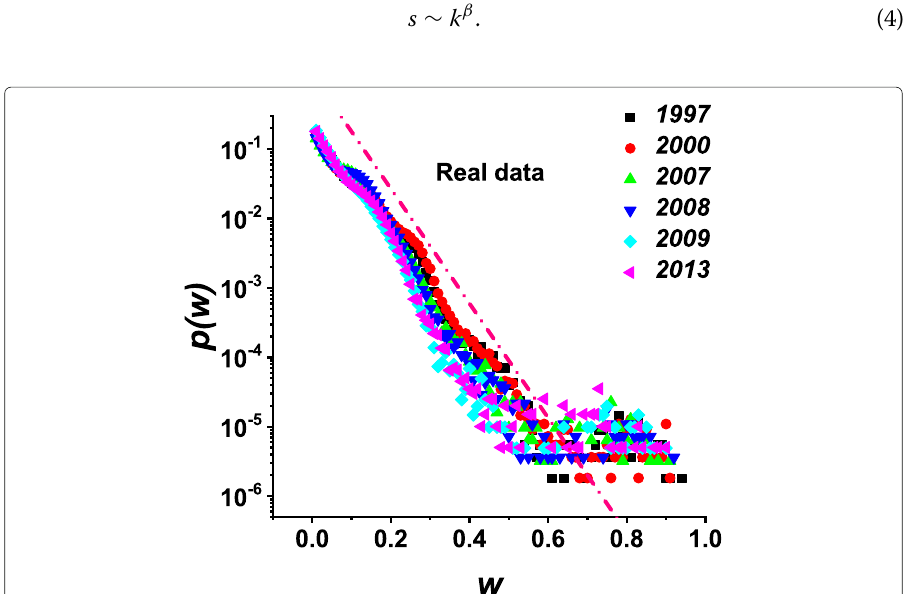
Fig. 2 The probability distribution functions of links weights for real networks of different years, the dashed line is a fitting line using an exponential